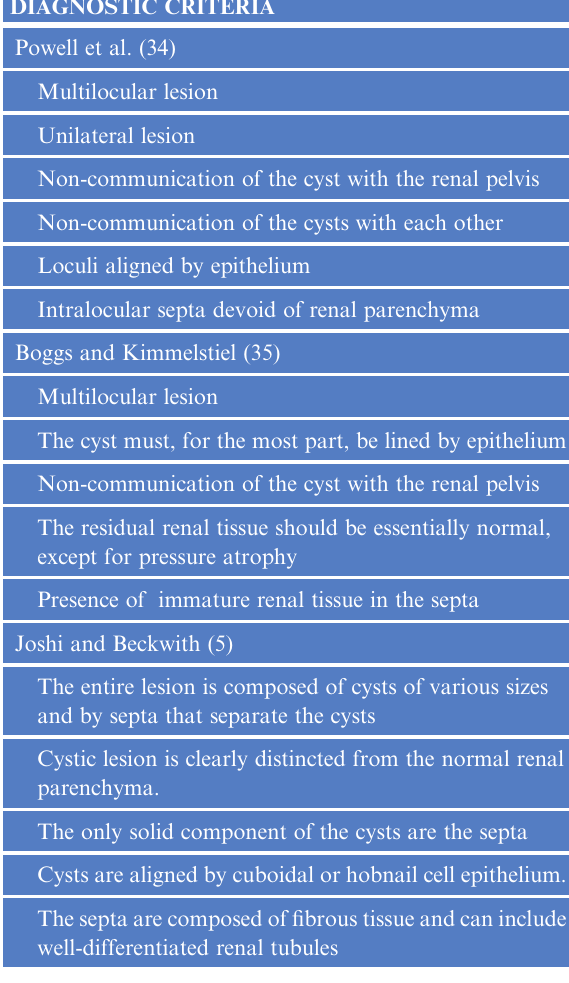
Table 3. Diagnostic criteria of CN